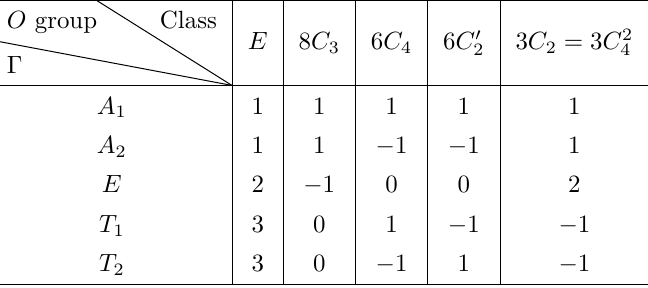
Table 6 . Character table for the O